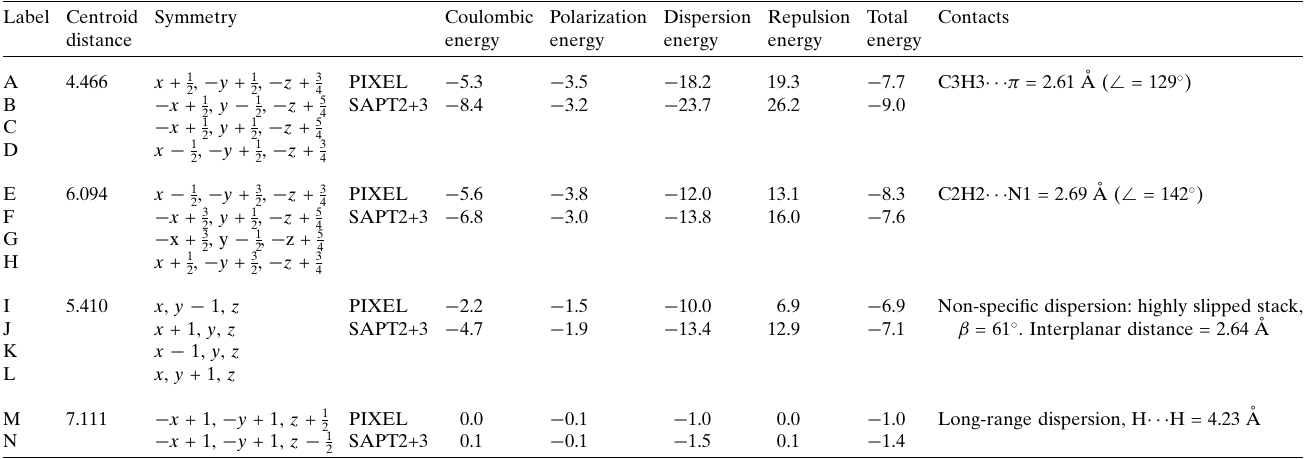
Table 2 Intermolecular contacts in pyridine III. All energies are in kJ mol (cid:5) 1 and contact distances (in A˚ ) were calculated with C—H distances reset to 1.089 A˚ . Label Centroid distance